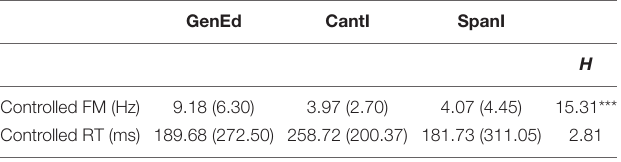
TABLE 4 | Mean (SD) performance on auditory tasks and analysis of variance.